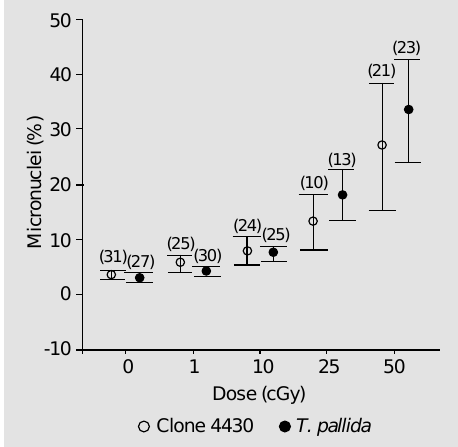
Figure 1. Radiosensitivity of Tra- descantia clone 4430 and T. pallida . Data are reported as means ± SEM as percent micro- nuclei measured in early tetrads of Tradescantia clone 4430 (open circles) and T. pallida (filled circles), 24 h after treatment with increasing doses of X-rays. The number of individuals stud- ied at each dose is given in pa-